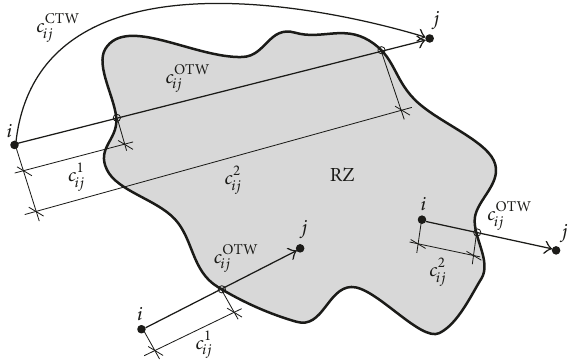
Figure 4: Cost structure of the links entering, leaving, and crossing the